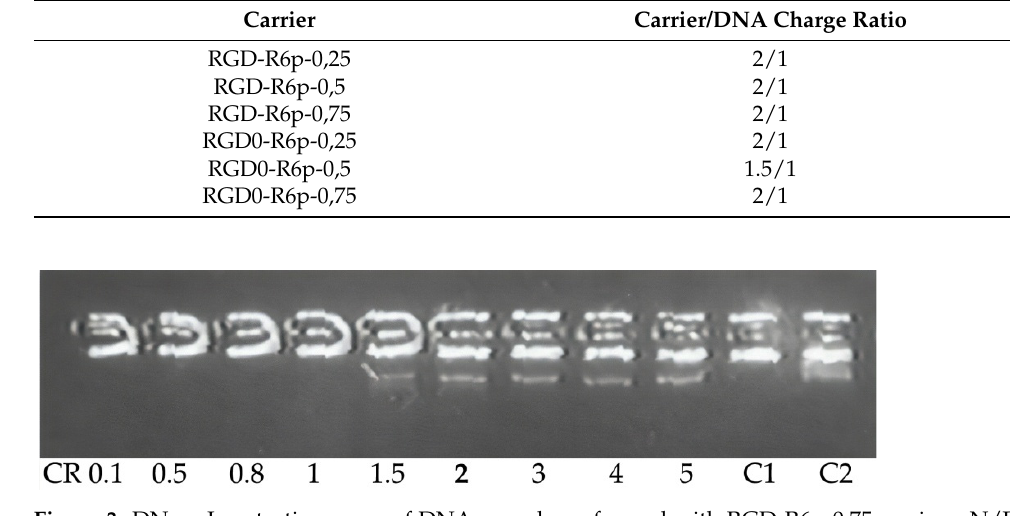
Figure 3. DNase I protection assay of DNA-complexes formed with RGD-R6p-0,75 carriers. N/P ratio in bold indicates the beginning of DNA protection. C–, ‘naked’ plasmid DNA treated with DNase I, C+, untreated plasmid DNA.